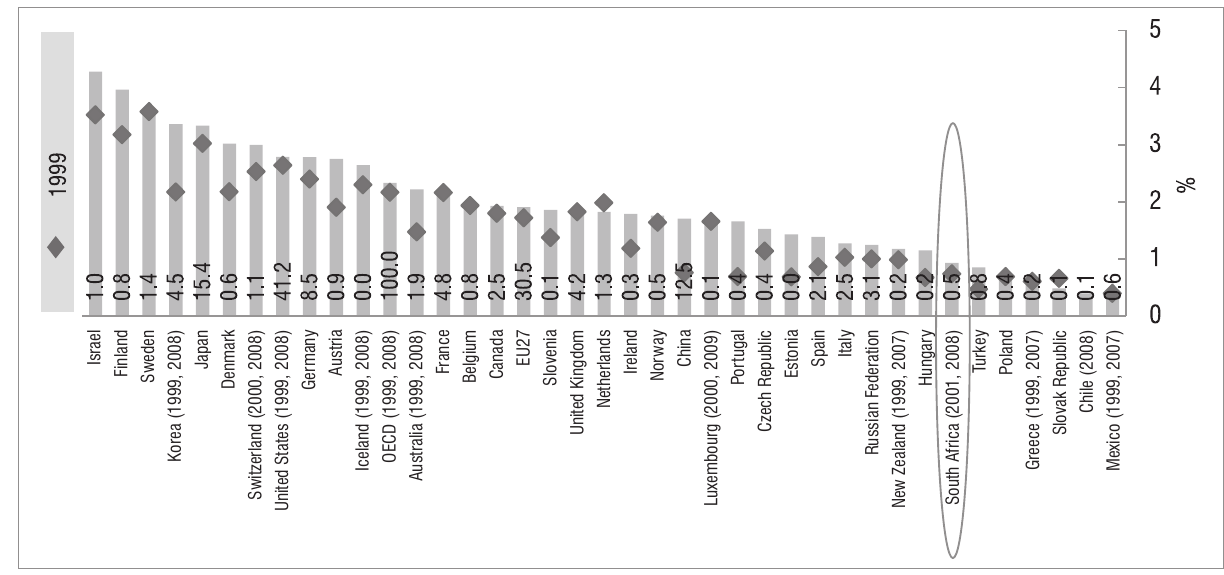
Figure 2: Gross domestic expenditure on R&D (% of GDP) in 1999 and